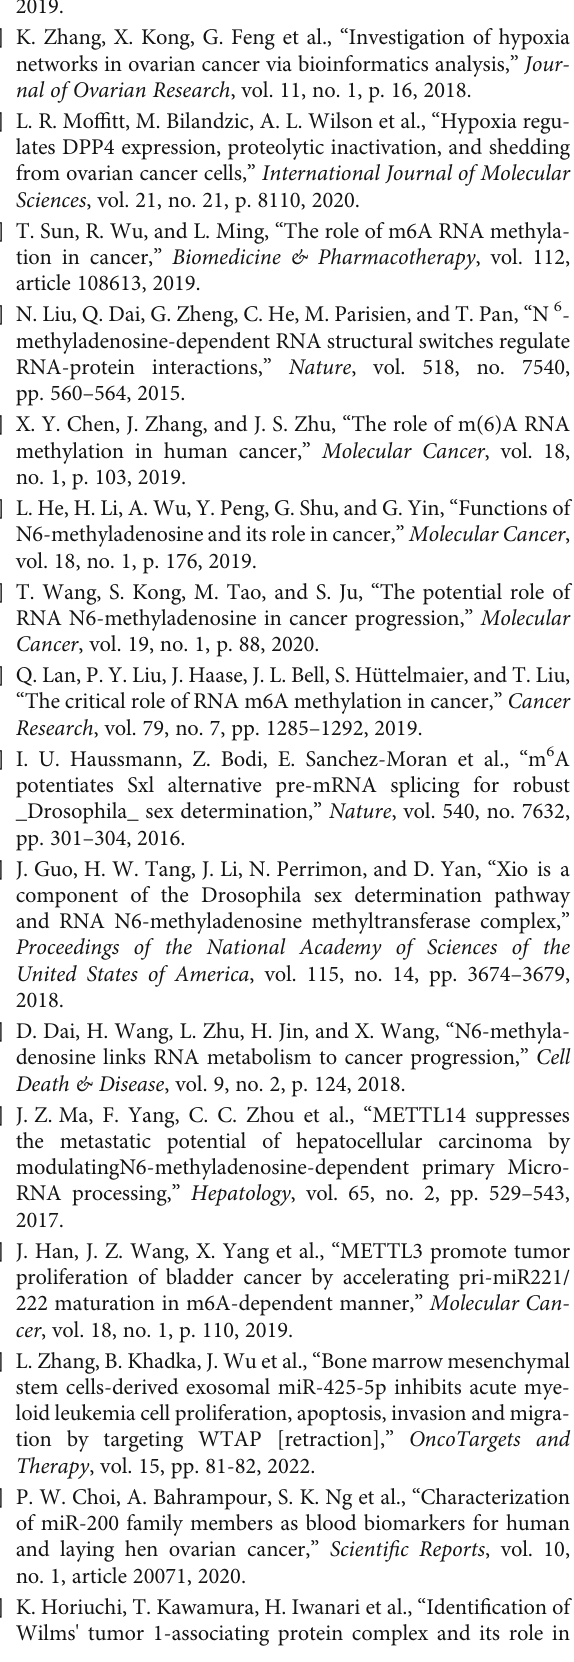
fi elds and demonstrated on the right panels. (G and H) Wound healing assay in WTAP-overexpressing cells. The scratch was measured 24 hours later. The cell boundary was outlined by the dotted black line. Quanti fi cation of wound healing percents was analyzed in H8901 and OVCAR8 cells, respectively. Data are means ±